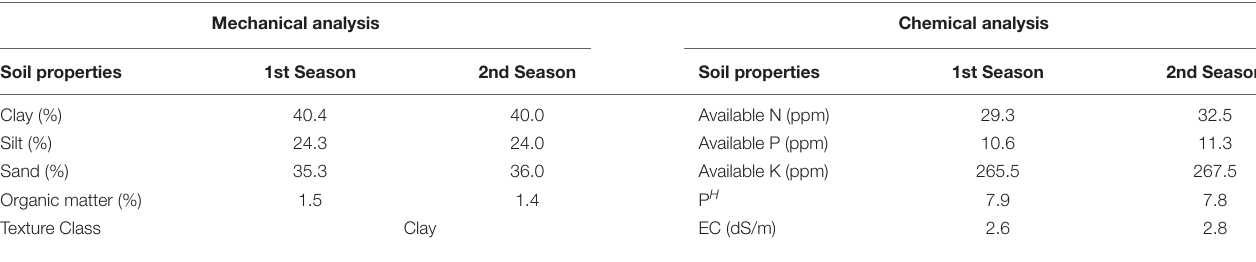
TABLE 1 | Some physical and chemical analysis of the experimental site in 2019 and 2020 seasons. Mechanical